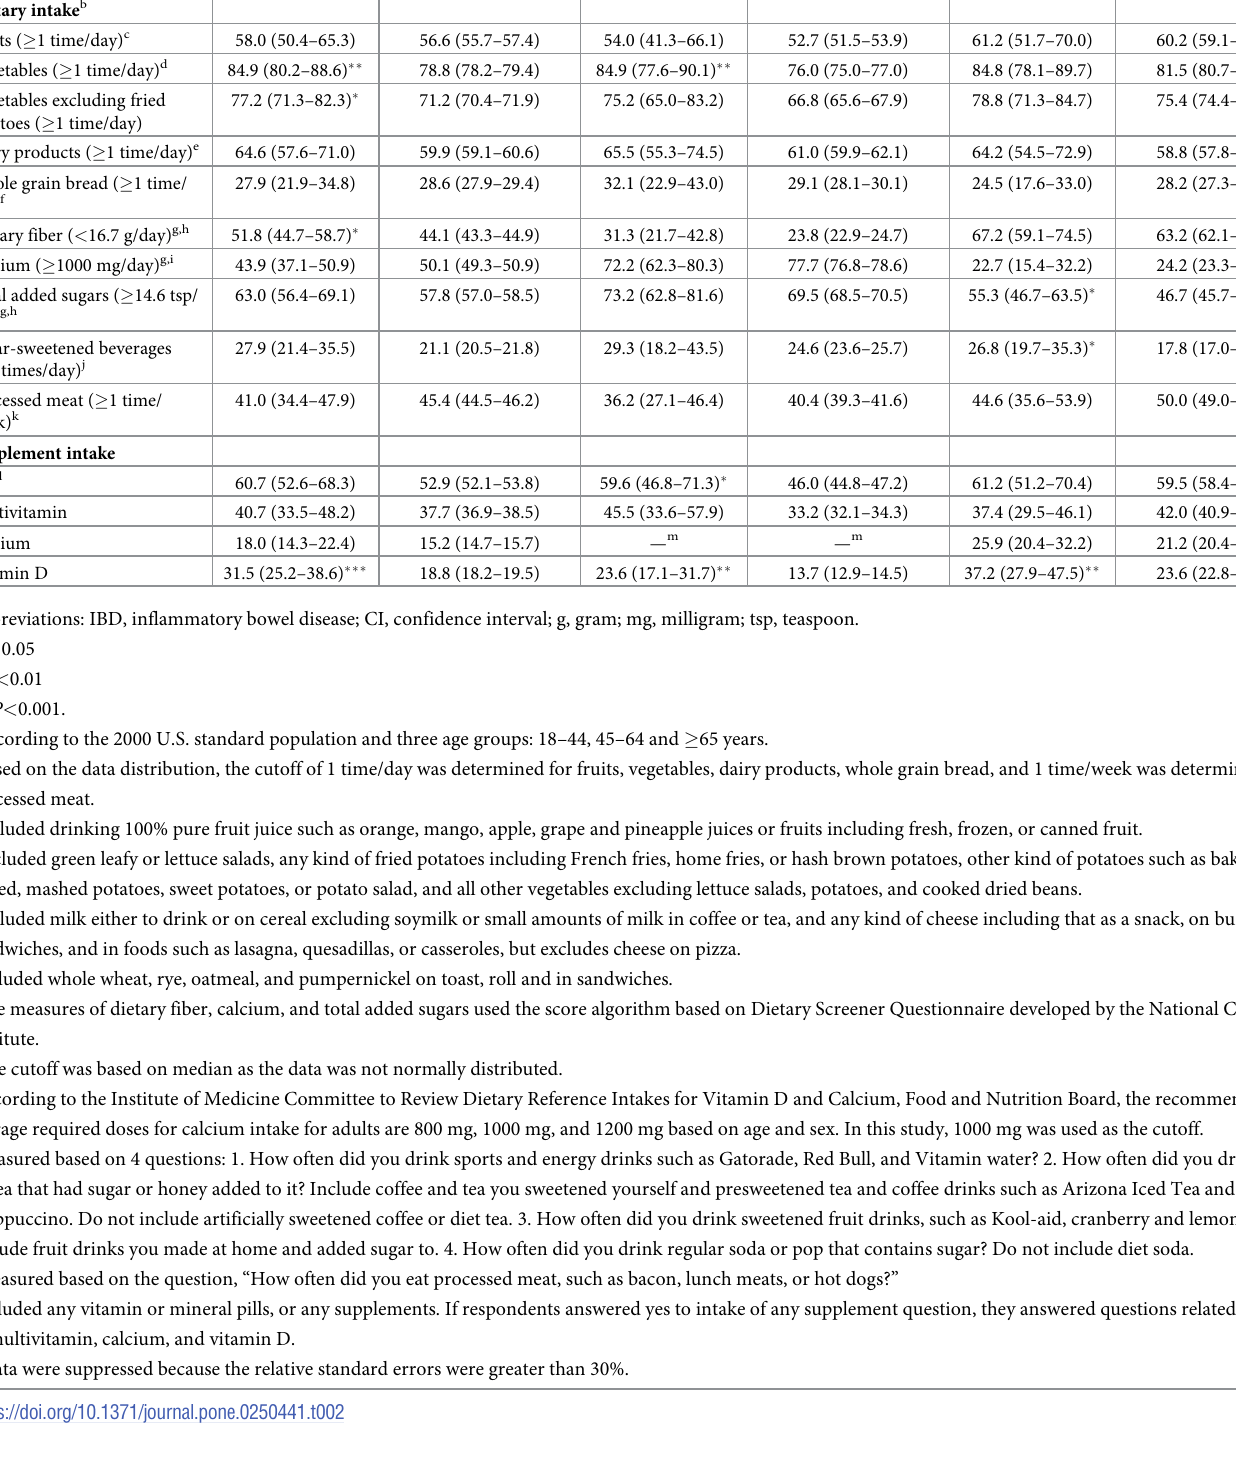
Table 2. Age-standardized a prevalence of dietary intake among adults with or without inflammatory bowel disease by sex, United States, 2015. Dietary or supplement intake All adults (N = 33,626) Men (n = 15,051) Women (n = 18,575) during the past month With IBD (n = 454) % (95%